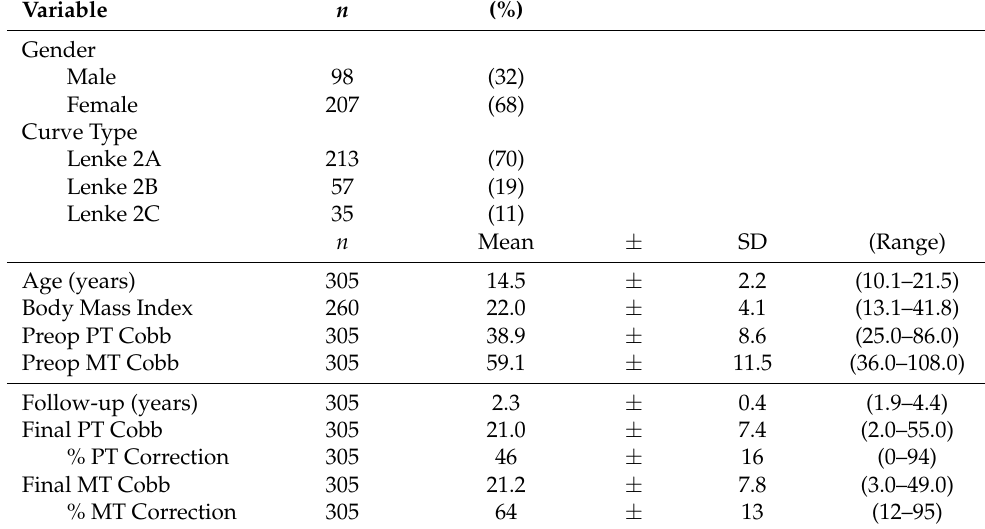
Table 1. Demographic characteristics.